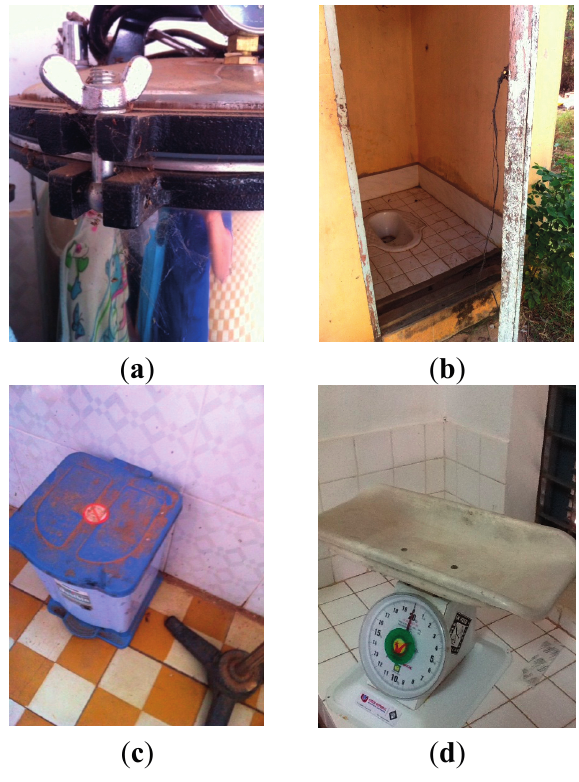
Figure 1. ( a – d ) Photos of health